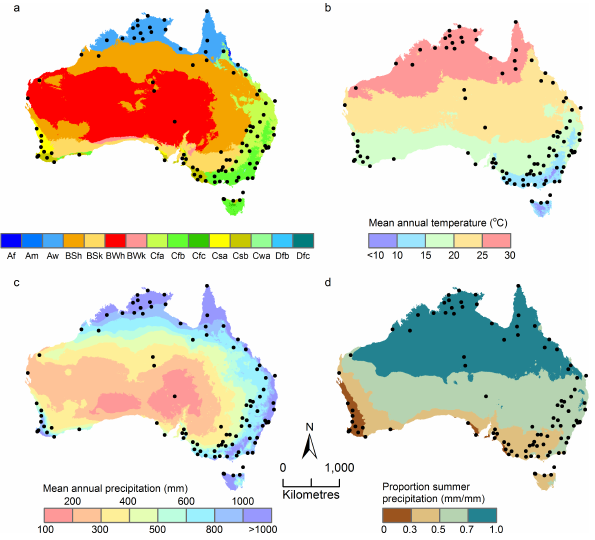
Fig. 1. Climate parameters (as mean over the period 1930–2010): (a) K¨oppen-Geiger climate zones; (b) annual temperature; (c) an- nual precipitation; (d) proportion of summer precipitation in an- nual mean rainfall; the points indicate the location where climate data was obtained for recharge modelling. Adapted from Barron et al. (2011); climate types Af, Am, Cfc, Cwa, Dfb and Dfc have lim- ited spatial distribution and combined they cover less than 1% of the